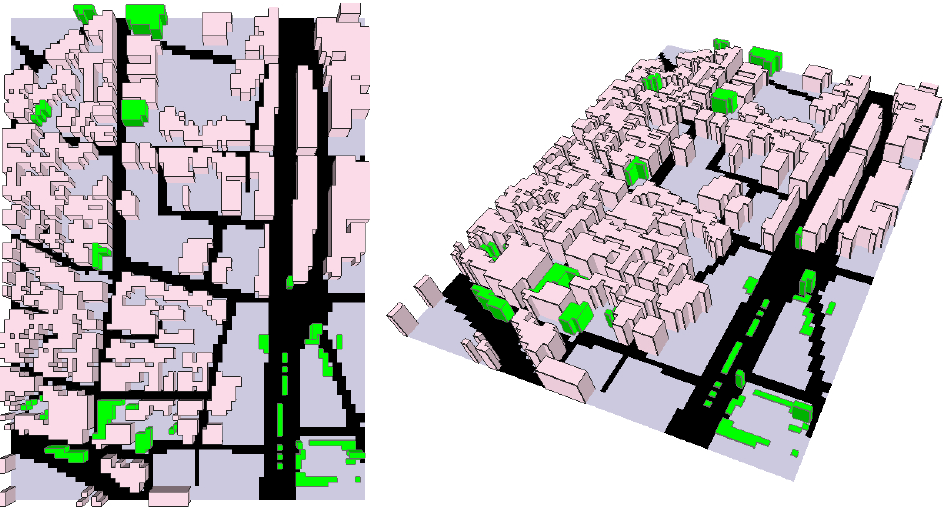
Figure 3. Three-dimensional computational domain of Bachoura District.